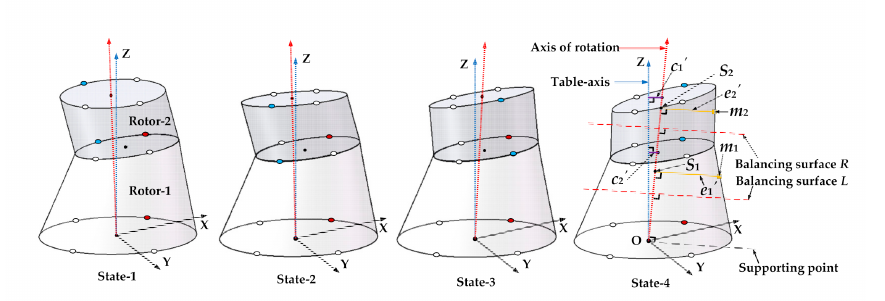
Figure 3. The table-axis and the axis of rotation in the different assembled state of a two-stage rotor after assembly.